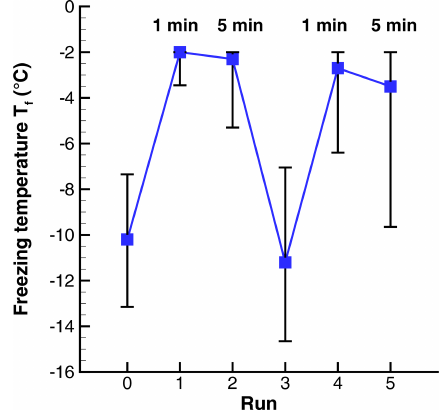
Figure 7. Freezing temperatures in a sequence of runs with 1 and 5min holding times at T w = + 1 . 5 ◦ C. The 50th percentile is indi- cated by symbols, and the vertical lines show the 5th- and 95th- percentile values.